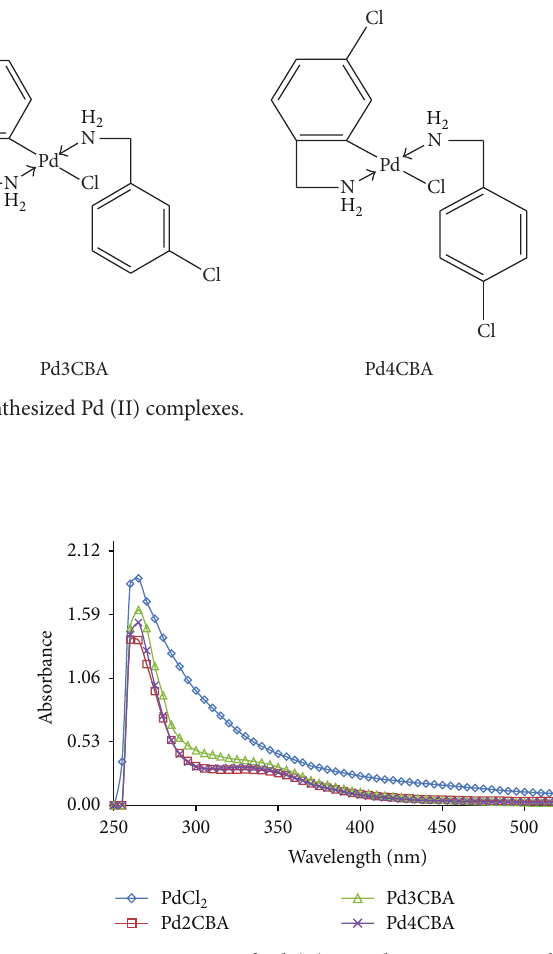
Figure 3: UV spectra of Pd (II) complexes in DMSO at 0.001 M.